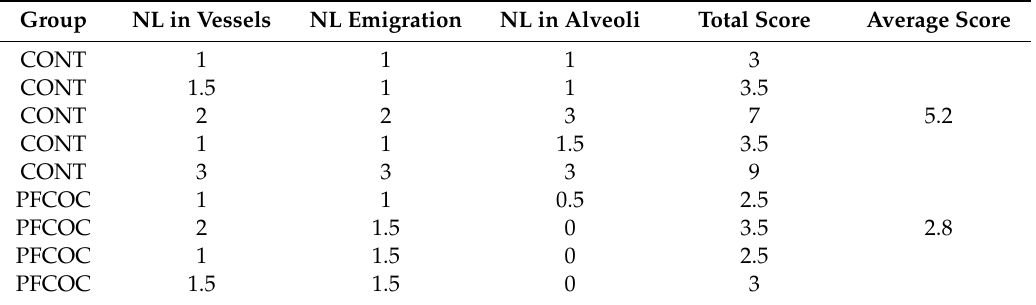
Table 4. Histologic score for inflammatory process observed after lung transplantation. Group NL in Vessels NL Emigration NL in